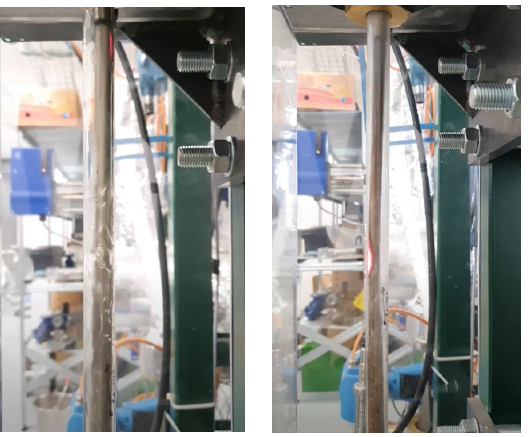
Figure 9. Dryout of tube surface